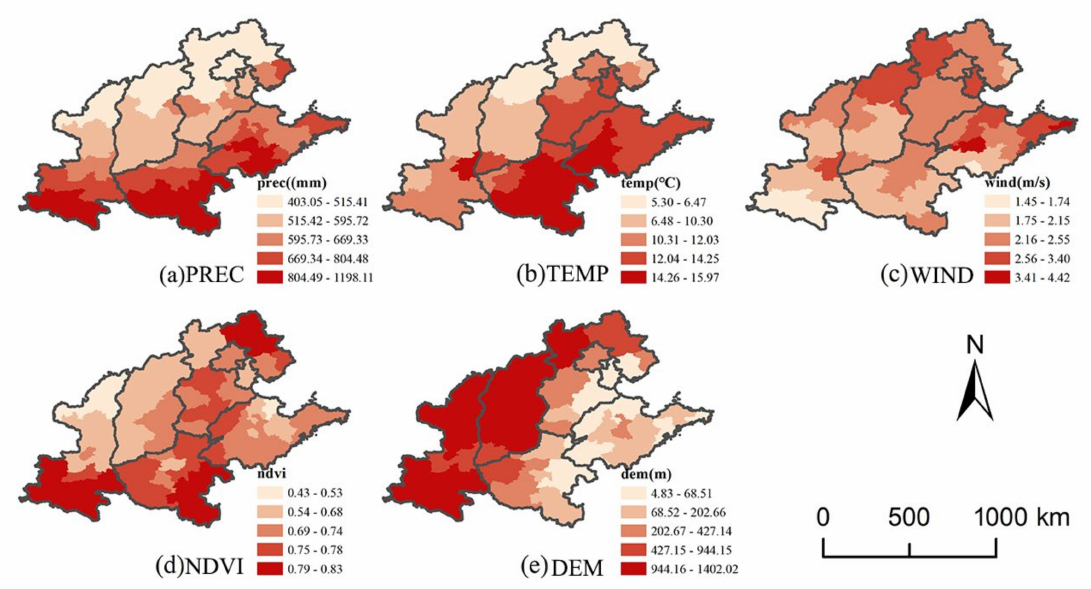
Figure 3. Spatial distribution of average values every three years of natural conditions from 2000 to